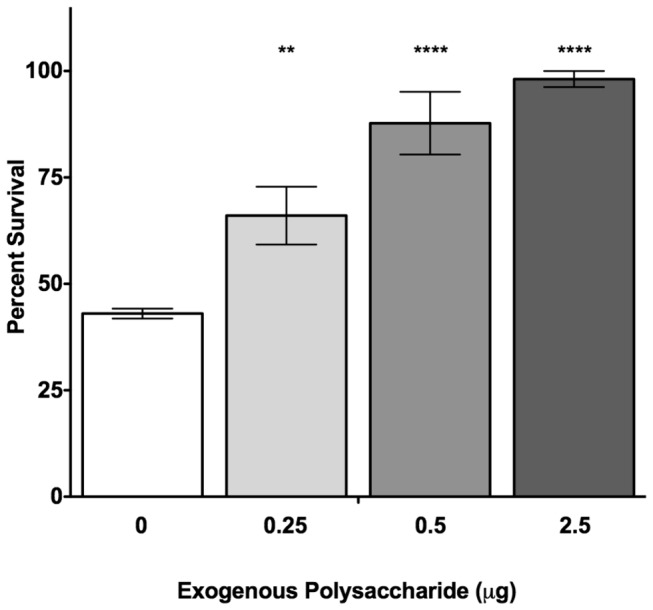
Exogenous EPEC polysaccharide protects against HD-5 killing.Survival of EPEC ∆gfcA∆waaL cells in the presence of 5 mM HD-5 supplemented with the indicated amount of EPEC polysaccharide purified from wild-type cells. The control does not have exogenous polysaccharide added to the sample. Results are expressed as means ± SEs of triplicate samples. Data shown are representative of at least three independent experiments. Asterisks indicate statistical significance compared to the control group; **, P <0.01; ****, P <0.0001 by two-way ANOVA and Bonferroni’s multiple comparison post
hoc test.